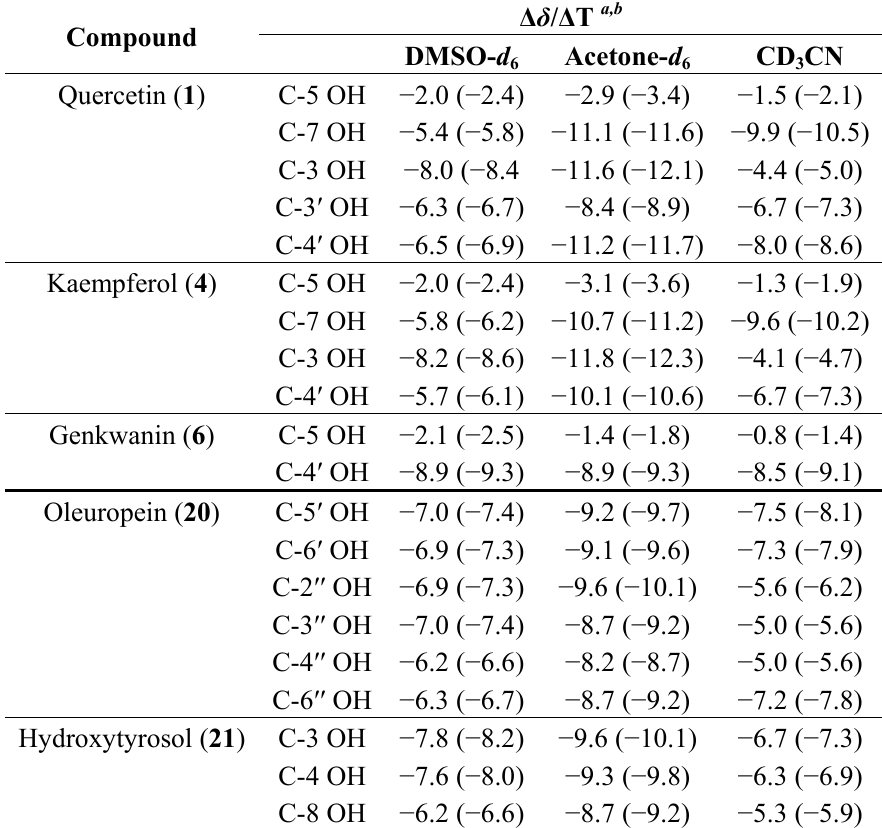
Table 4. Chemical shift temperature coefficients (Δ δ /ΔT) a,b of hydroxyl protons of quercetin ( 1 ), kaempferol ( 4 ), genkwanin ( 6 ), oleuropein ( 20 ), and hydroxytyrosol ( 21 ), in DMSO- d , acetone- d , and CD CN solution. Reprinted with permission from [25]. 6 6 3 Copyright 2013, The Royal Society of Chemistry.